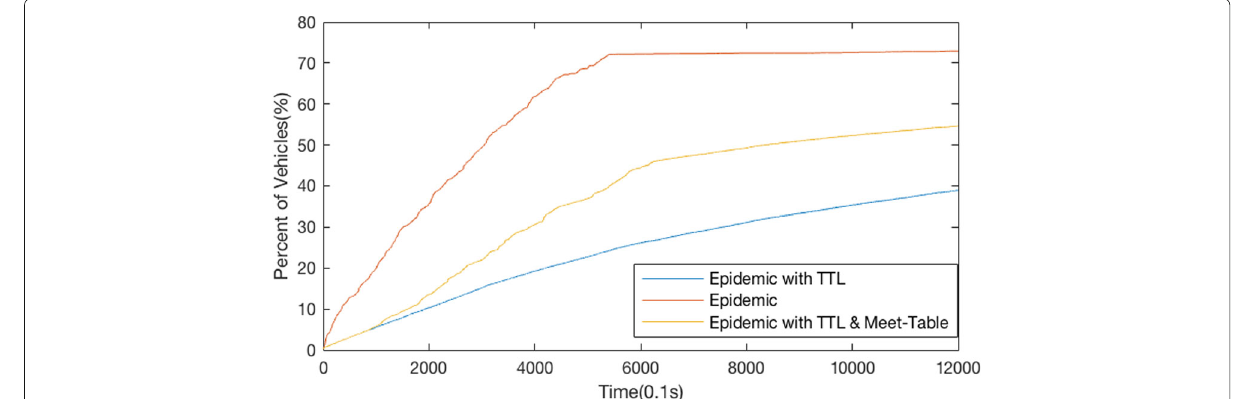
Fig. 3 Time vs. percent of vehicles possessing